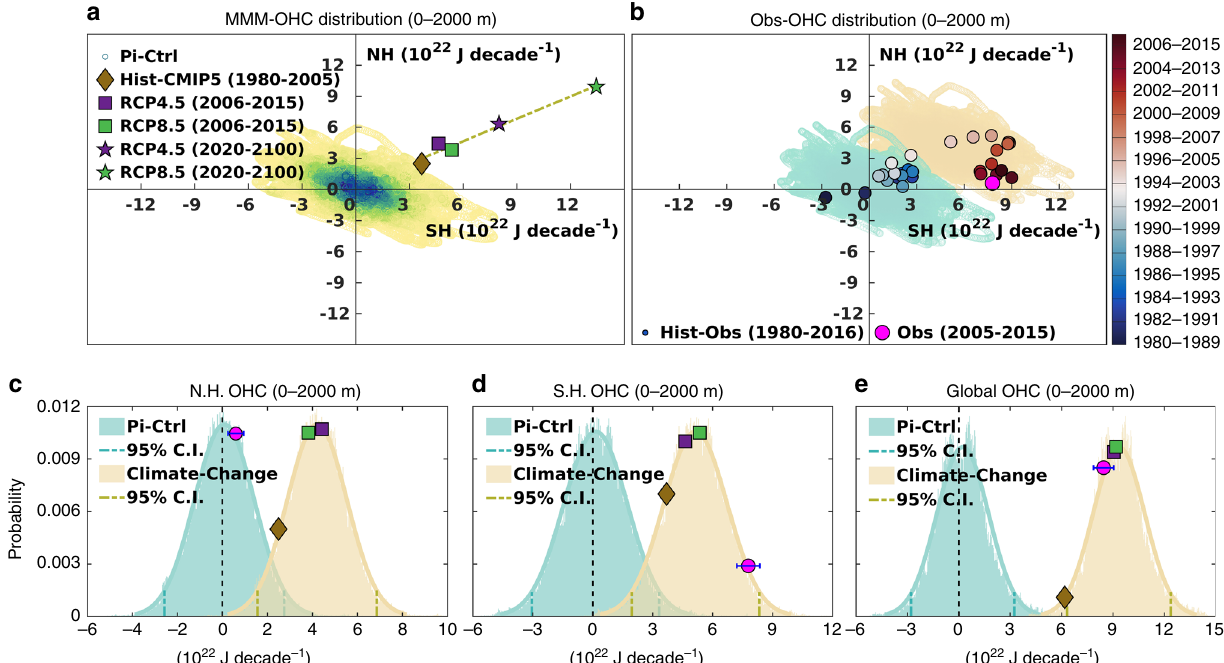
Fig. 3 Probabilistic analysis of the ocean heat content anomaly trend. Distribution of the linear trend of the OHC anomaly (10 22 J decade − 1 ) for the depth of 0 – 2000m for Northern (NH) and Southern Hemisphere (SH) from ( a ) multi model ensemble (MME) of pre-industrial control (Pi-Ctrl) simulation (cloud), with the multi model mean (MMM) trend from the historical (Hist-CMIP5, brown diamond, 1980 – 2005), RCP 4.5 (purple square 2006 – 2015; purple star 2020 – 2100) and RCP 8.5 (green square 2006 – 2015; green star 2020 – 2100) simulation, and the least square fi t line passing through these points to represent the direction of climate change ( b ) the green cloud is the same as shown in ( a ) and the orange cloud is the represent the climate change signal in the direction of the best fi t line as shown in ( a ), Observed trend over the period of 2005 – 2015 (Obs, pink circle) along with the trajectory (scatter dots) of the 10-year running trends from the long-term observations over the period of 1980 – 2016 (Hist-Obs). c Probability distribution curve for the northern hemisphere ’ s internal variability (green cloud in ( b )) and climate change (orange cloud in ( b )) with the OHC trend from observations (pink circle with the error bar of 95% con fi dence intervals from two-sided student ’ s t -test, 2005 – 2015), MMM of historical (brown diamond, 1980 – 2005), RCP 4.5 (purple square, 2006 – 2015) and RCP 8.5 (green square, 2006 – 2015) simulations. d , e Same as ( c ) but for the Southern Hemisphere and the Global Ocean respectively. The 95% con fi dence interval for the probability distribution curves is derived from the 2-sigma limits for the gaussian distribution of OHC